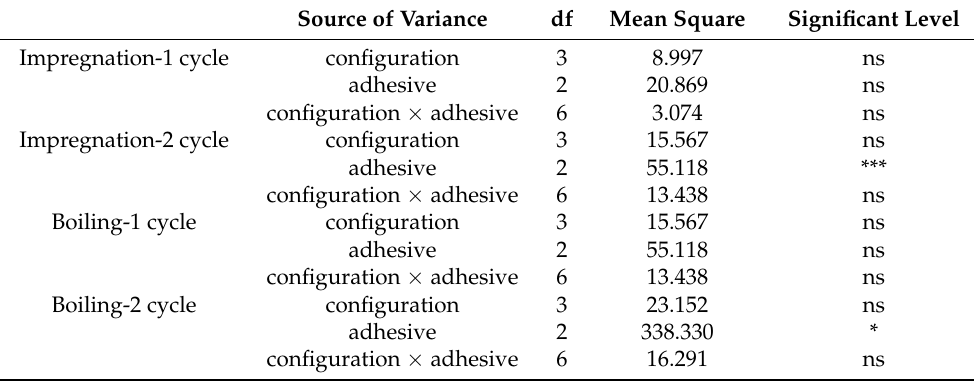
Table 6. ANOVA results of